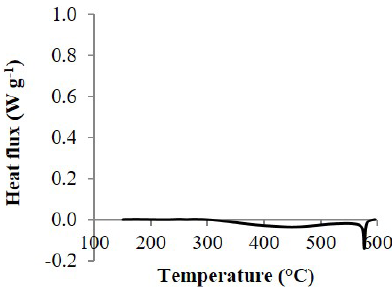
Figure 3. Differential scanning calorimetry thermograms of the subsoil (argic horizon) of a haplic Luvisol, H 2 O 2